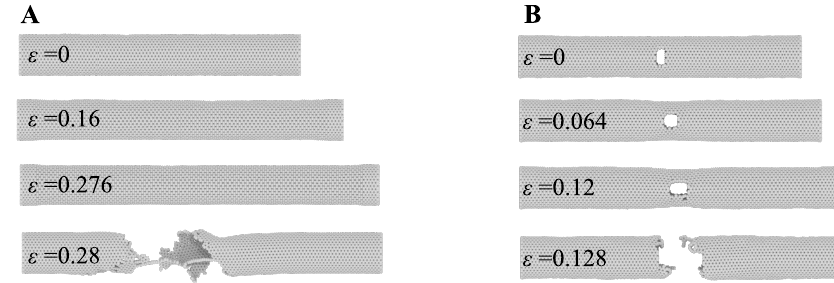
Figure 5. The snapshots show the fracture of ( A ) the SWCNT without crack and ( B ) the cracked SWCNT under constant pulling velocity.